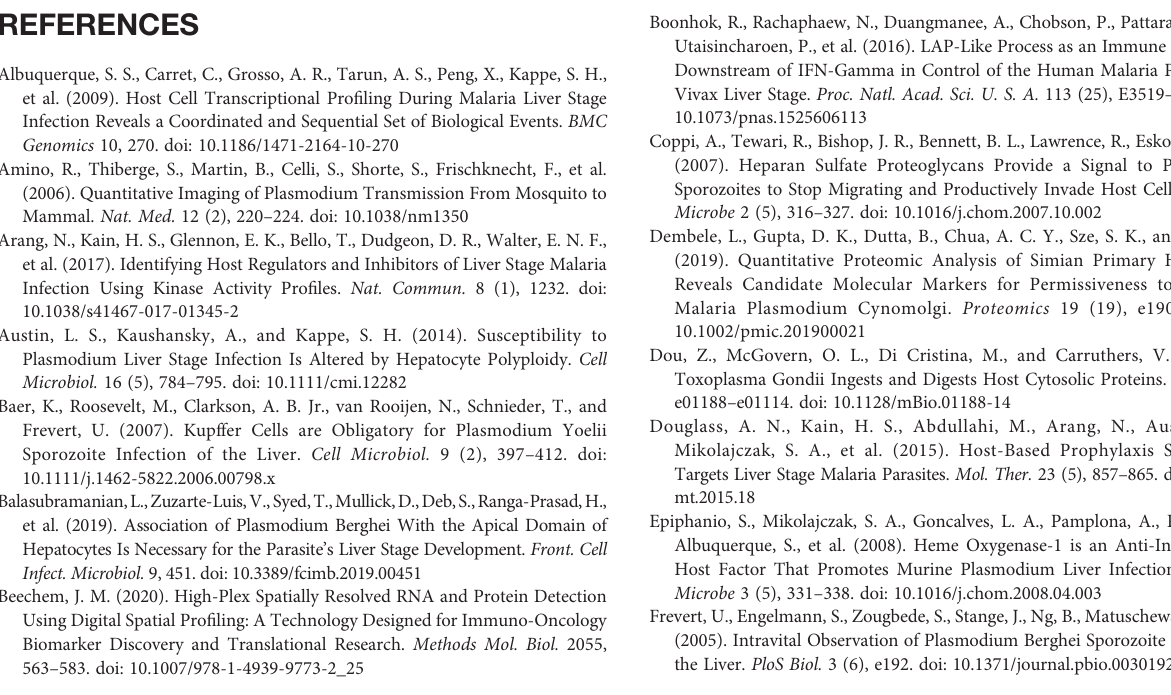
Supplementary Figure 1 | DSP results are reproducible across runs and between pooled and single ROIs. Average fold change between infected and uninfected ROIs for each antibody from (A) two independent DSP runs, and (B) two slides run at the same time. Data were analyzed by linear regression. (C) For each antibody the average area-normalized signal 9 single infected ROIs was plotted against that of one pooled infected ROI, all from the same mouse. (D) For each antibody the average area-normalizedsignal9singleuninfectedROIswasplottedagainstthatofonepooled uninfectedROI.Datawereanalyzedbylinearregression. (E) Representativeimagesof uninfected regions total magni fi cation of 400x at 44hpi. Supplementary Figure 2 | A subset of upregulated (phospho)proteins in proximity to Plasmodium -infected hepatocytes are correlated. (A) Heat map indicating the Pearson correlation coef fi cient for each pair of antibodies for those signi fi cantly upregulated in Ring1 compared to Ring2. Antibodies from multiple panels are identi fi ed as part of panel (A) or (B) . n = 6 matched ROI sets from a single mouse. Supplementary Figure 3 | Growth of Plasmodium infected hepatocyte does not account for increased Kupffer cell density around cell. Kupffer cell density within circular ROIs of55µm and 65µm around parasites at 24hpi and 44hpi. Parasitesare shown as green circles. Length of lines is indicated in microns. Circles and rings are shown to scale. Kupffer cell density is shown as the mean from 3-4 parasites per mouse from 3 mice per time